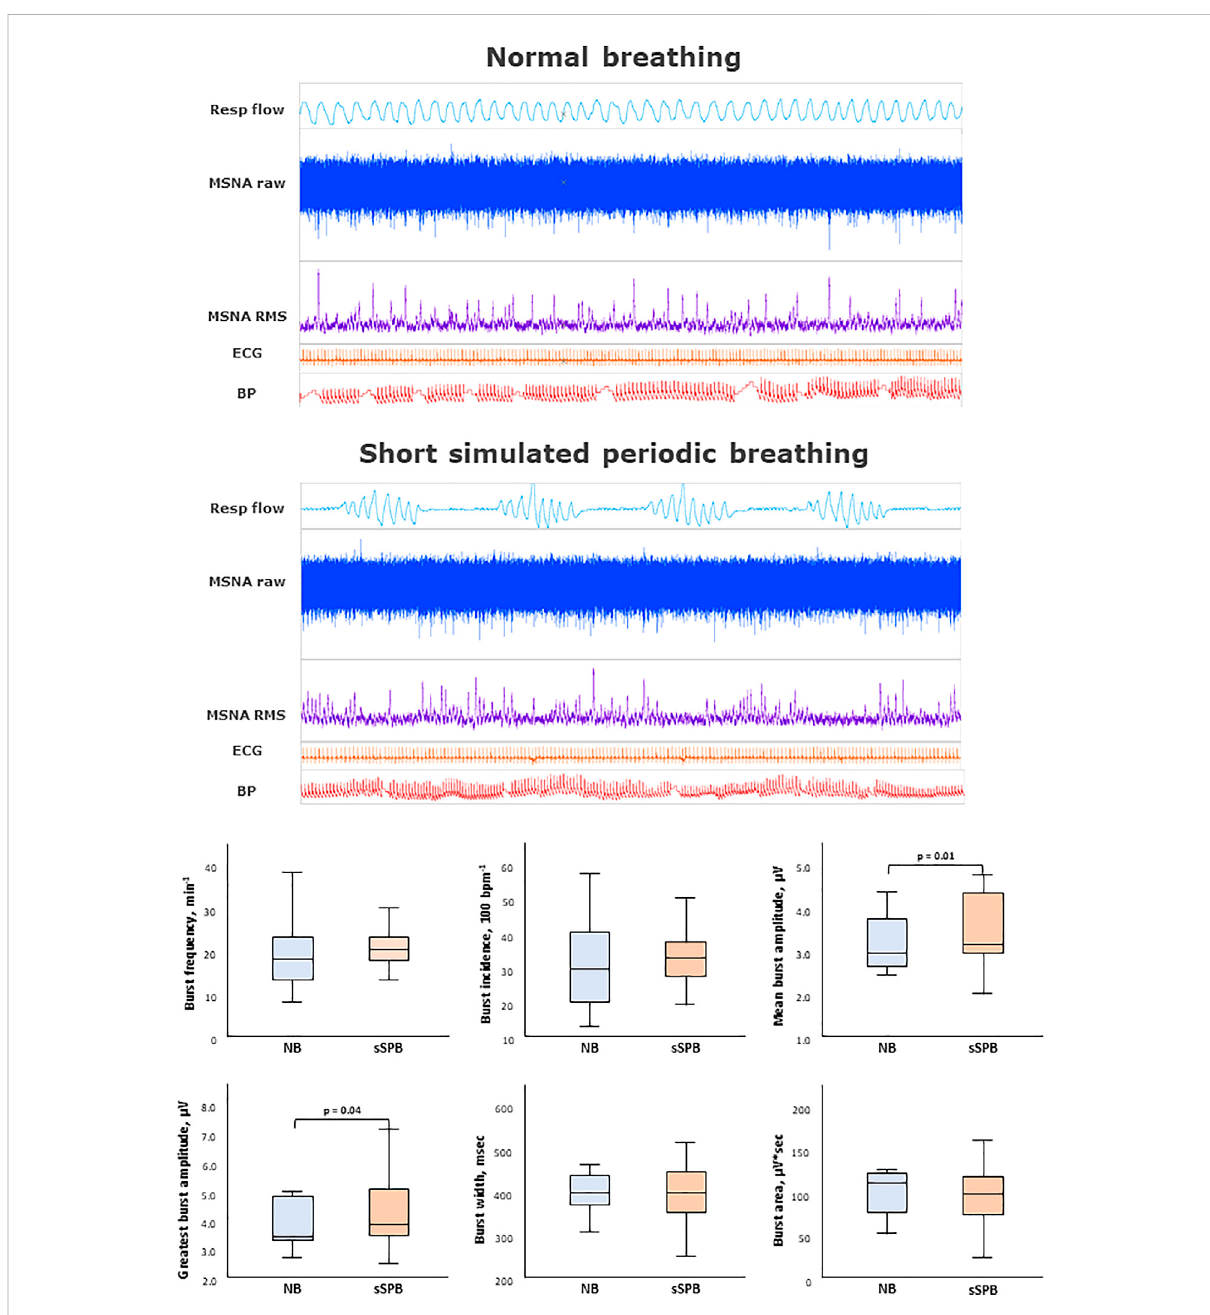
FIGURE 2 Impactofshortsimulatedperiodicbreathingonmusclesympatheticnerveactivity.Multi-unitrecordingofmuscleSNA.RMS,rootmeansquare, BP, blood pressure; Resp fl ow, respiratory fl